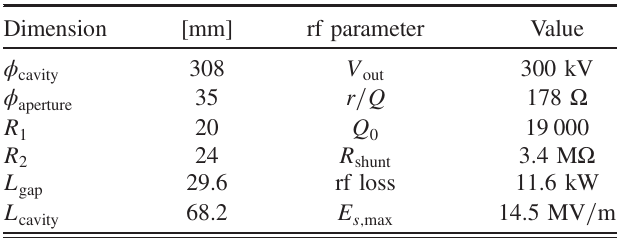
TABLE II. Parameters of the 650 MHz rf gun with a thermionic cathode.